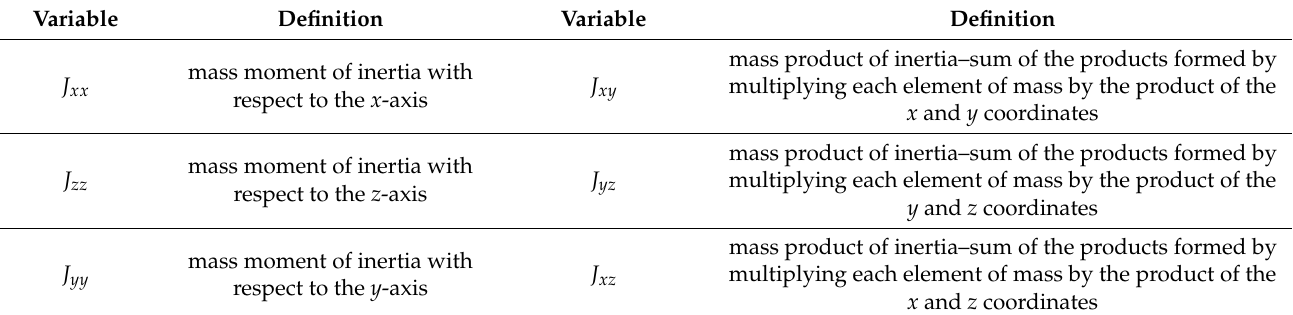
Table 2. Definitions of variables proximal to the Table